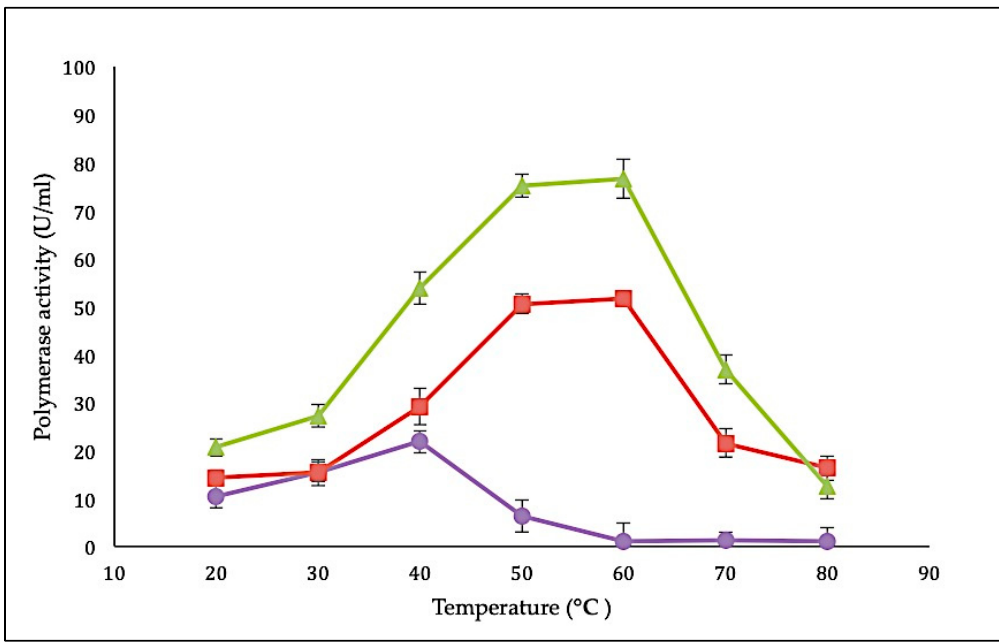
Figure 4. Effect of temperature on SK72 DNA polymerase activity and its variants. Optimal temperature was determined by varying the assay temperatures. Symbols represent the enzyme variants; SK72 (filled square), SK72-Exo (filled triangle), and SK72-Exo2 (filled circle). Error bars represent standard deviation ( n = 3) The absence of the bar indicates that the error is smaller than symbols.